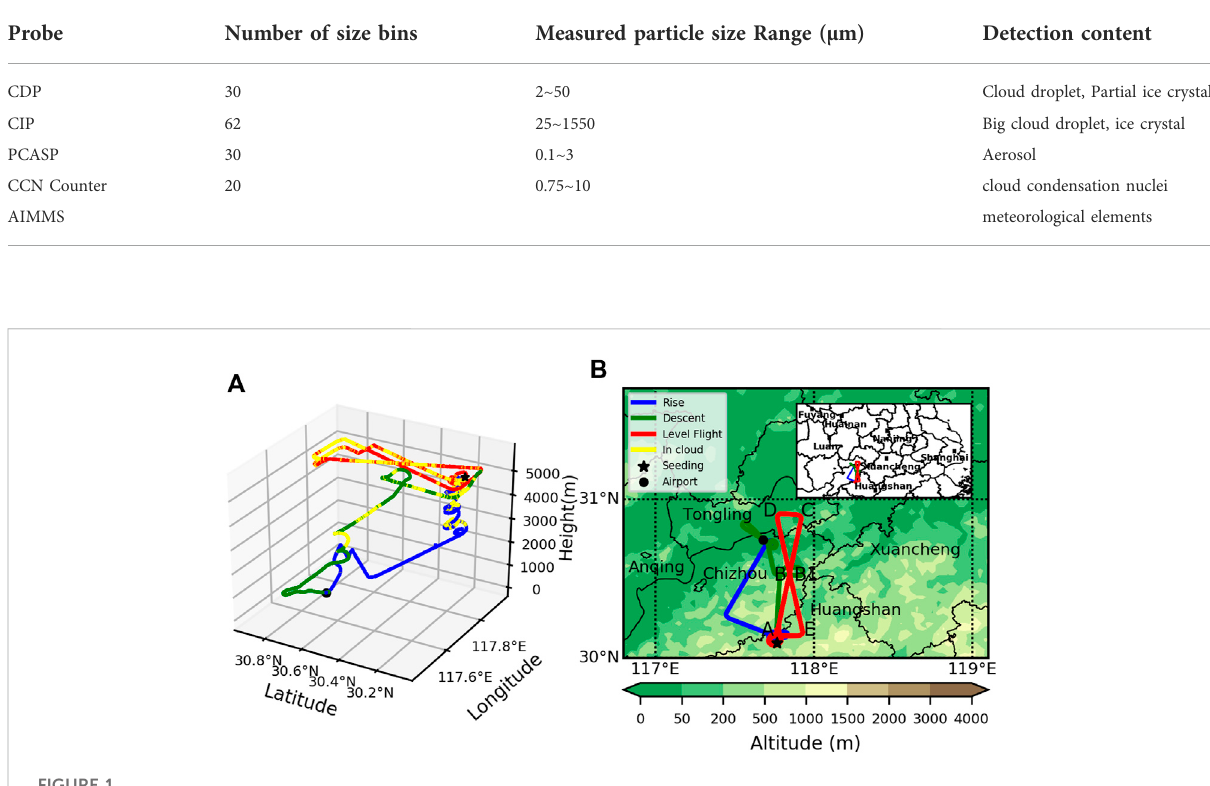
FIGURE 1 (A) Flight trajectory and (B) its vertical view over southern Anhui on 1 November 2020. Blue line is ascent track, red line is horizontal fl ight and green line is descent track. Color shading represents the terrain heights using NOAA data (https://www.ngdc.noaa.gov). A, C, D, E are four turning points, and B, B1 is overlapped points on the